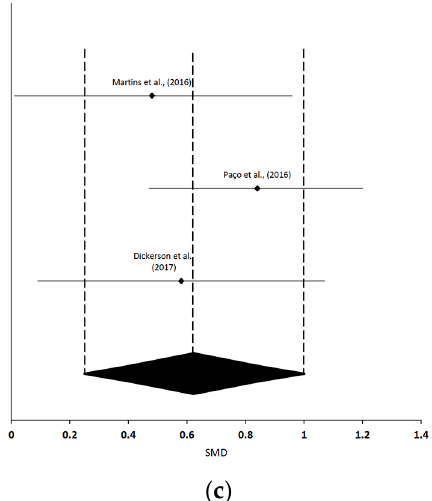
Figure 5. Synthesis forest, funnel and sensitivity plots of combined manual therapy and therapeutic exercise intervention on maximum mouth opening variable in patients with TMD [19,61,63]. ( a ) The forest plot summarizes the results of included studies (standardized mean differences (SMD) and weight). The small squares represent the point estimate of the effect size and sample size. The lines on either side of the box represent a 95% confidence interval. ( b ) Funnel plot aims to assess the existence of publication bias. ( c ) Sensitivity plot.